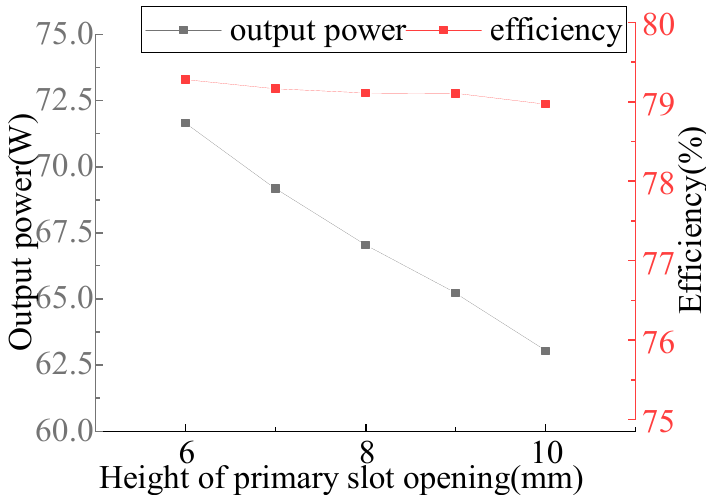
Figure 14. Relationships between output power and efficiency and the height of primary slot open- ing.